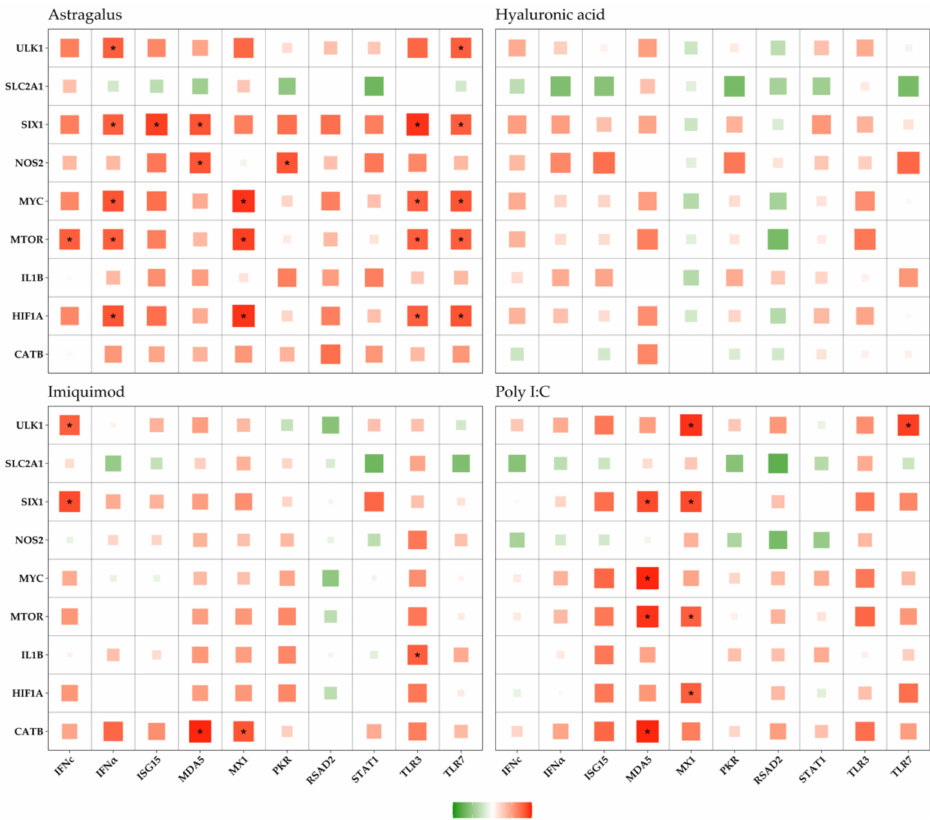
Figure 3. Spearman’s rank correlation between immune (x-axis) and metabolic genes (y-axis) in Astragalus, Hyaluronic acid, Imiquimod, and Poly I:C. Correlation varies between − 1 (negatively correlated; green color) and 1 (positively correlated; red color). The size of the squares and depth of color indicate the strength of correlation. Asterisks indicate p <